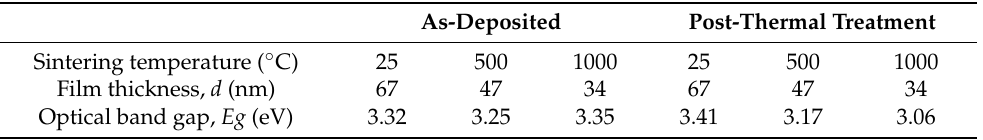
Table 2. The estimated band gaps ( Eg ) of TiO 2 thin films deposited from unsintered and sintered targets, before and after thermal